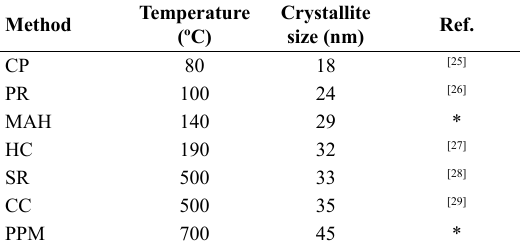
Table 1. Comparative results between the crystallite size by Debye–Scherrer formula obtained in this work (*) with those published in the literature. CP = Co-precipitation, PR = Precipitation, MAH = Microwave-assisted hydrothermal, HC =